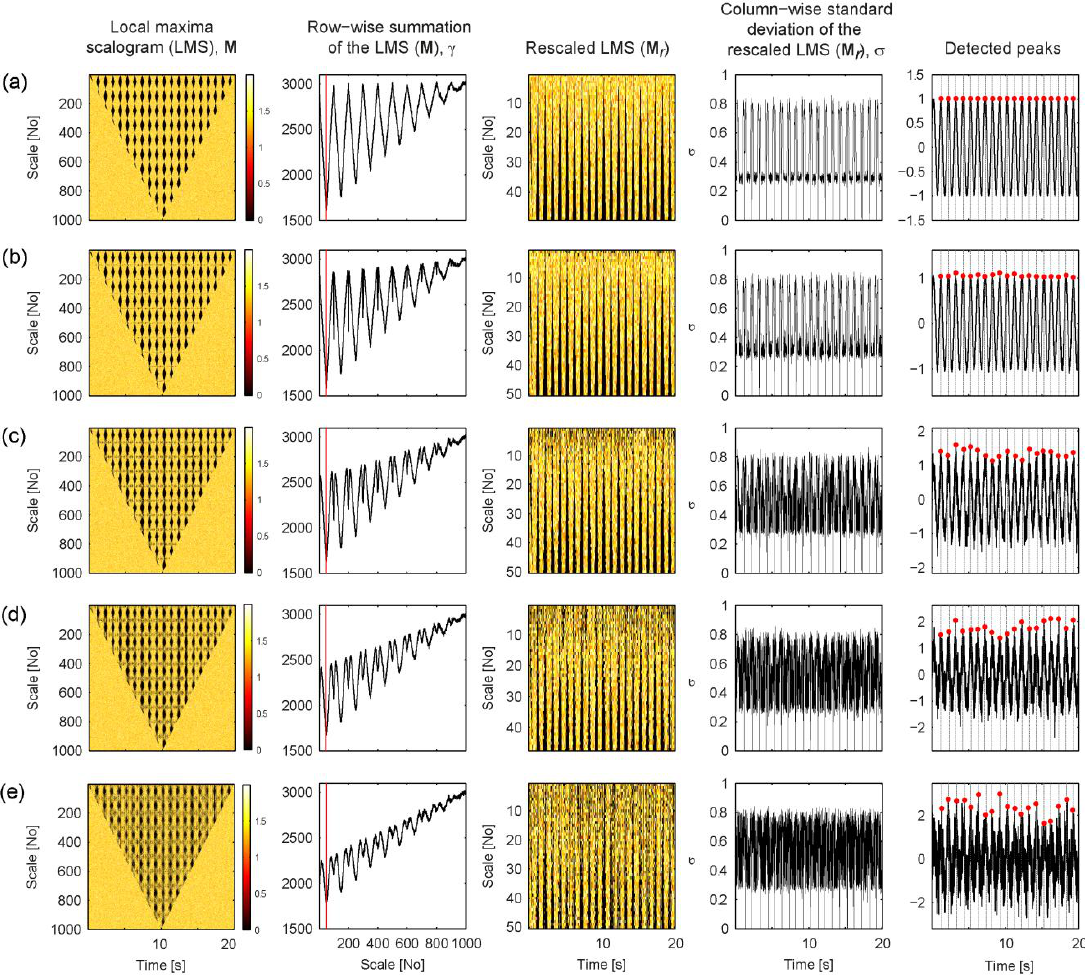
Figure 3. Results of applying the AMPD algorithm to the simulated type A data